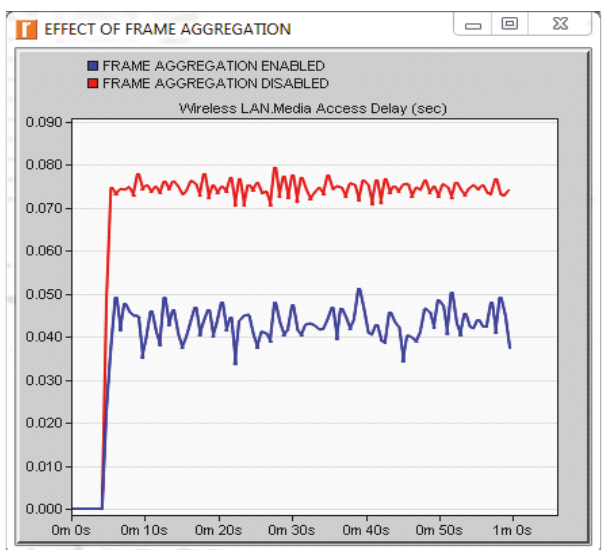
Figure 37: WLAN media access delay with and without frame